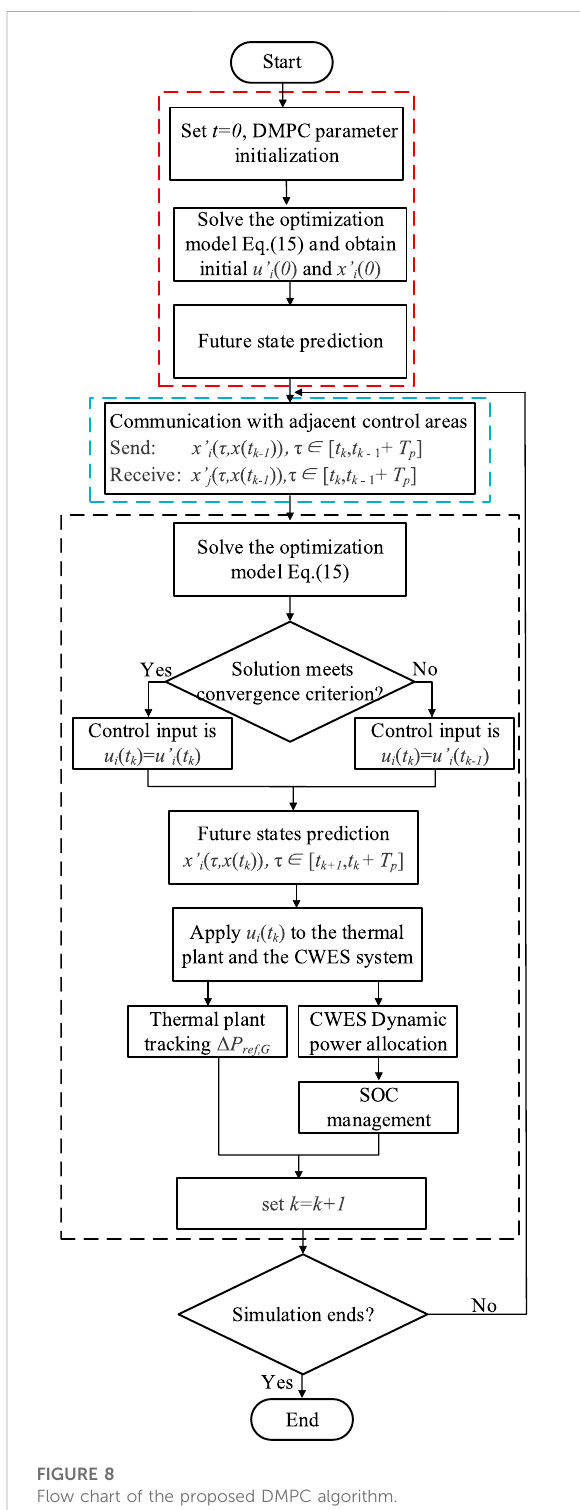
FIGURE 8 Flow chart of the proposed DMPC